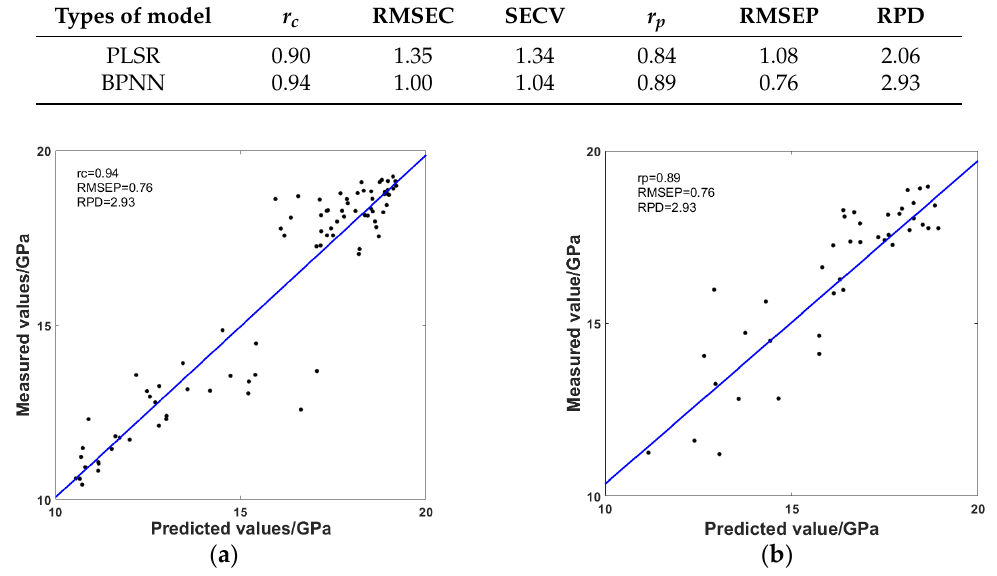
Figure 7. Relationships between the measured and predicted MOE of Quercus mongolica in the ( a ) calibration set and ( b ) prediction